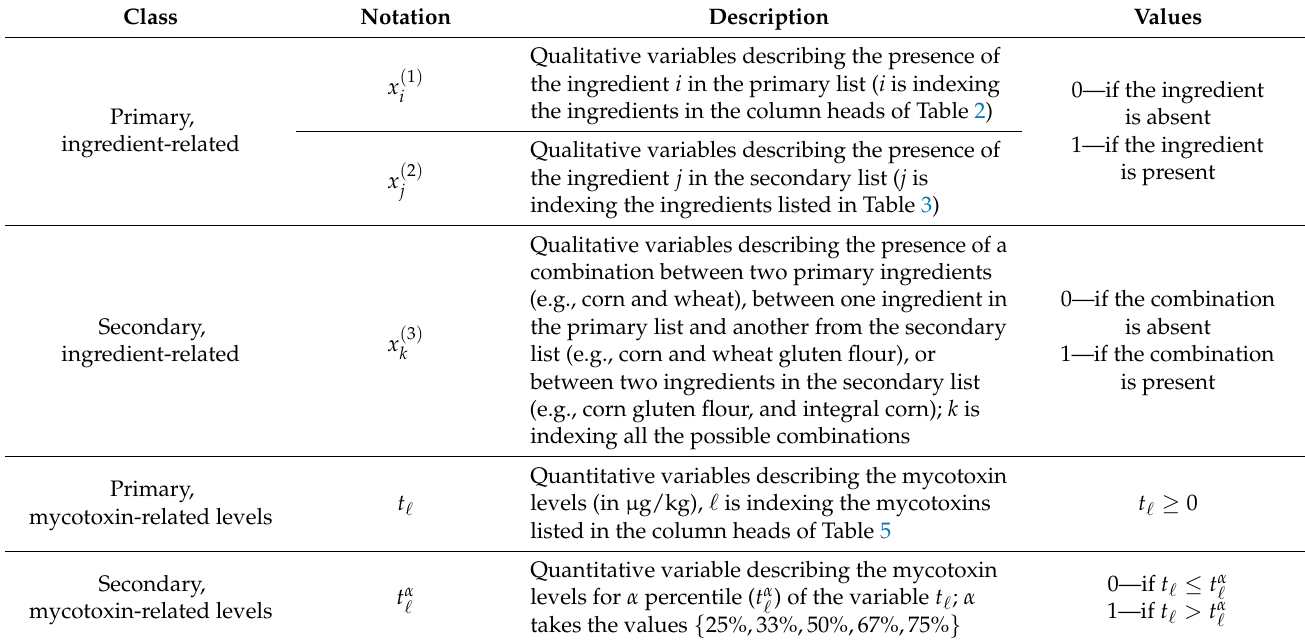
Table 4. Primary and secondary ingredient and mycotoxin levels-related variables.